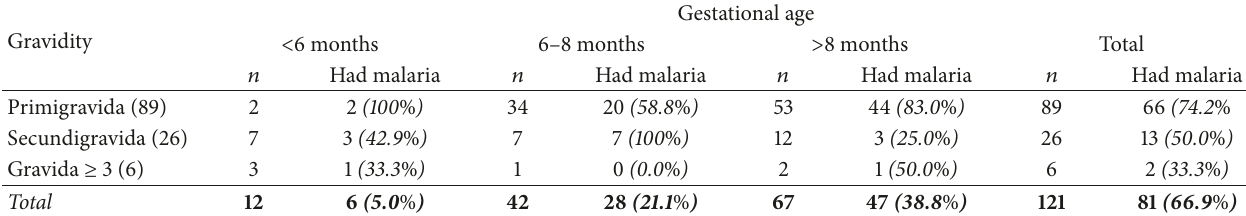
Table 2: Cross-tabulation of gravidity and gestational age with incidence of malaria in present pregnancy.